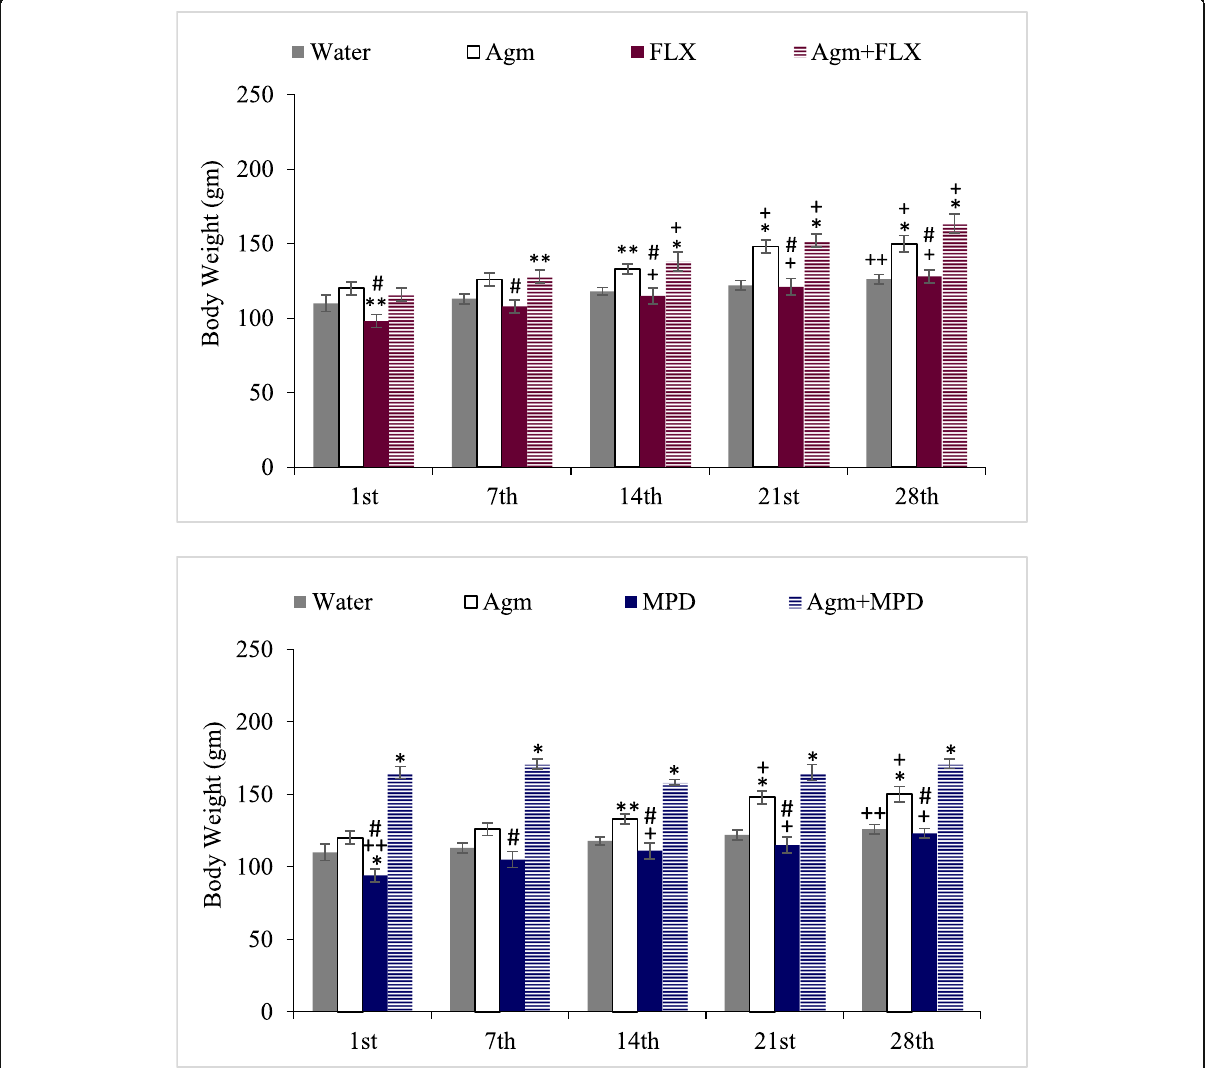
Fig. 3 Body weight: values are expressed as means ± SD ( n =6). Significant differences by Newman-Keuls test: * p <0.01, ** p <0.05 from water- treated control group to drug-treated groups. + p <0.01, ++ p <0.05 from drug ’ s 1st administration. # p <0.01, ## p <0.05 from AGM-treated animals